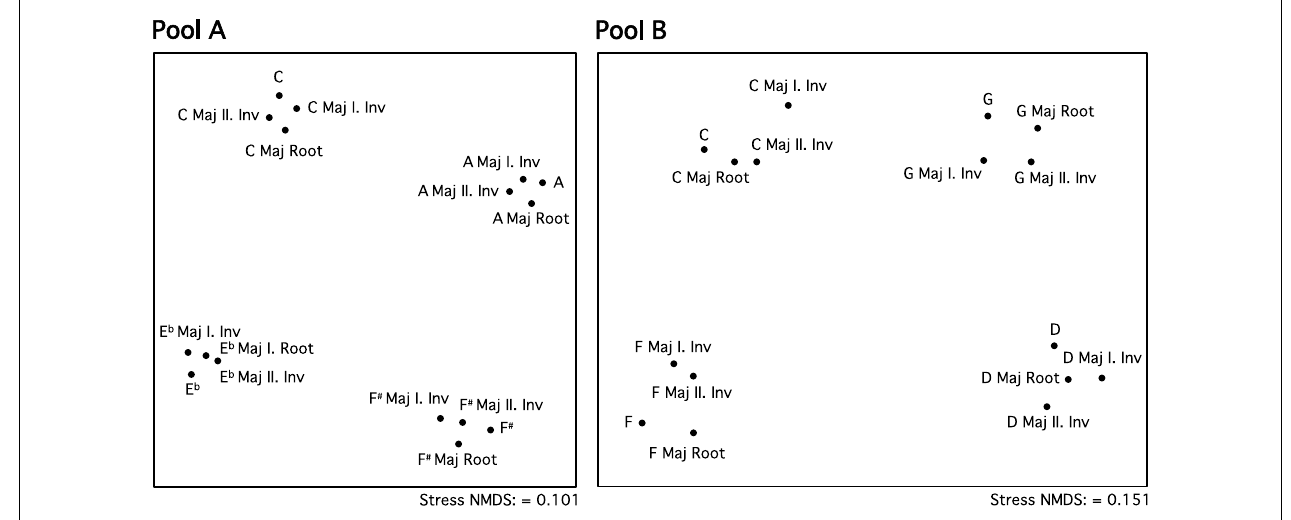
expert vs. novice comparisons by means of evaluating the AvgLoss ( = average deviation of a certain novice map from the expert map) for each individual, which thus represents the spatial discrepancy between the individual novice and the expert solution at certain points of time (abbreviations: root = root position of a major chord; 1./2. Inv = first/second inversion of a major